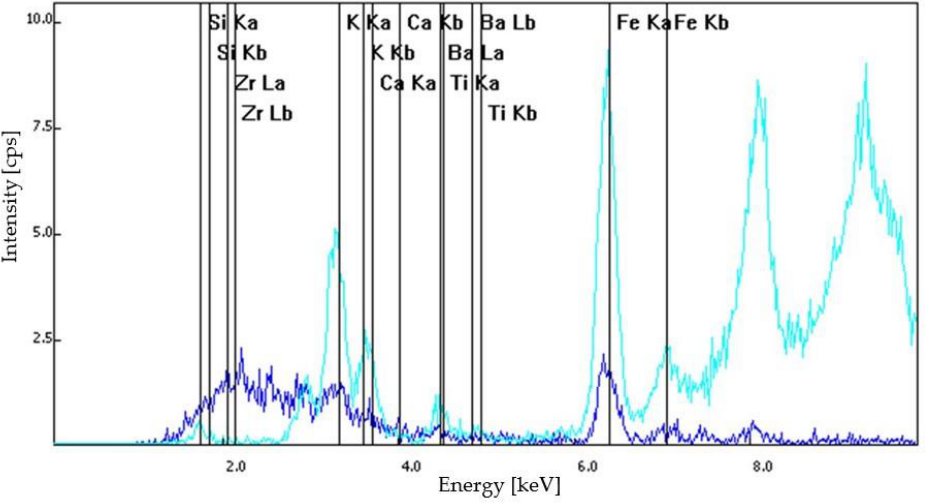
Figure 9. S2 sample series: XRF spectra.